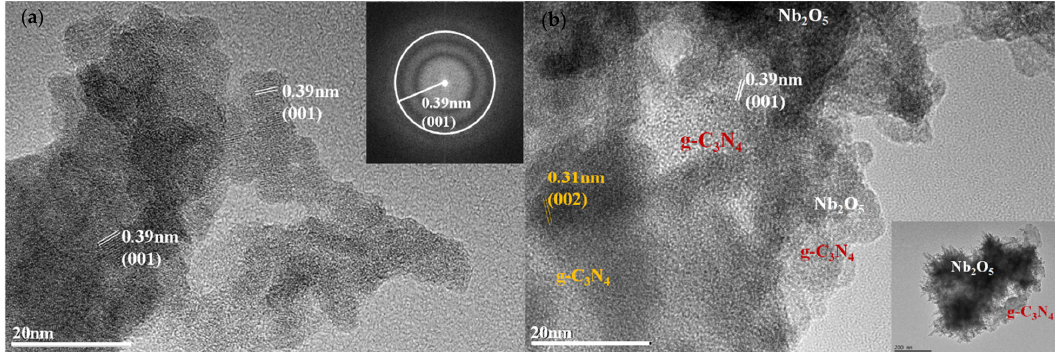
Figure 7. ( a ) HRTEM (high electron transmission electron microscopy) image and SAED (selected area electron diffraction) pattern (inset) of NBO, ( b ) HRTEM image and TEM (inset) image of NBCN‐2.